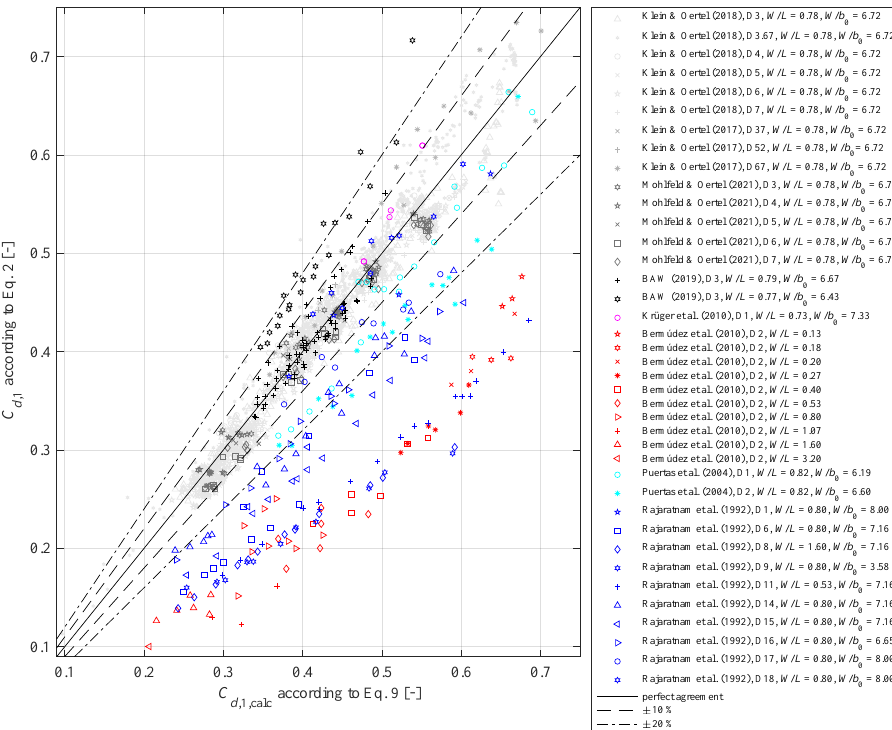
Figure 5. Comparison of calculated discharge coefficients according to Equations (2) and (9) with error bounds of ± 10% and ± 20%